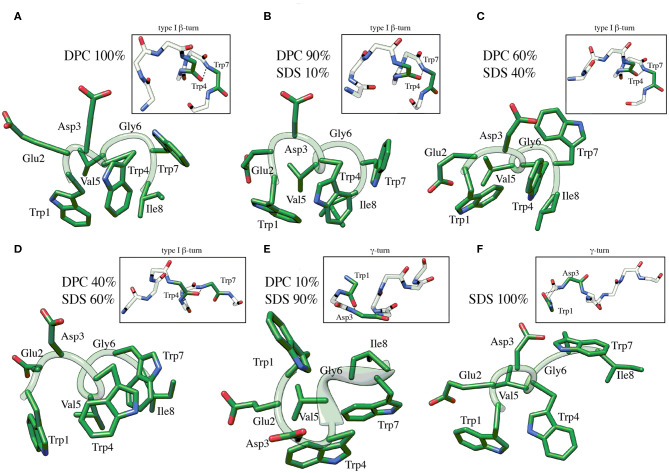
Low energy NMR models calculated for C8 in DPC/SDS molar ratio: 90:10 (B), 60:40 (C), 40:60 (D), 10:90 (E). NMR models in pure DPC (A) and in pure SDS (F) were previously published (Scrima et al., 2014), and they are now shown for comparison. The calculation was carried out using standard CYANA protocol of simulated annealing in torsion angle space (10,000 steps) applying interprotonic distances as restraints collected from NOE data. The H-bond between the carbonyl O of Trp4 and the amide NH of Trp7 that is specific for the type I β-turn structure is reported in the insets of (A–D). The H-bond between the carbonyl O of Trp1 and the amide NH of Asp3 that is specific for the γ-turn structure is reported in the insets of (E,F).